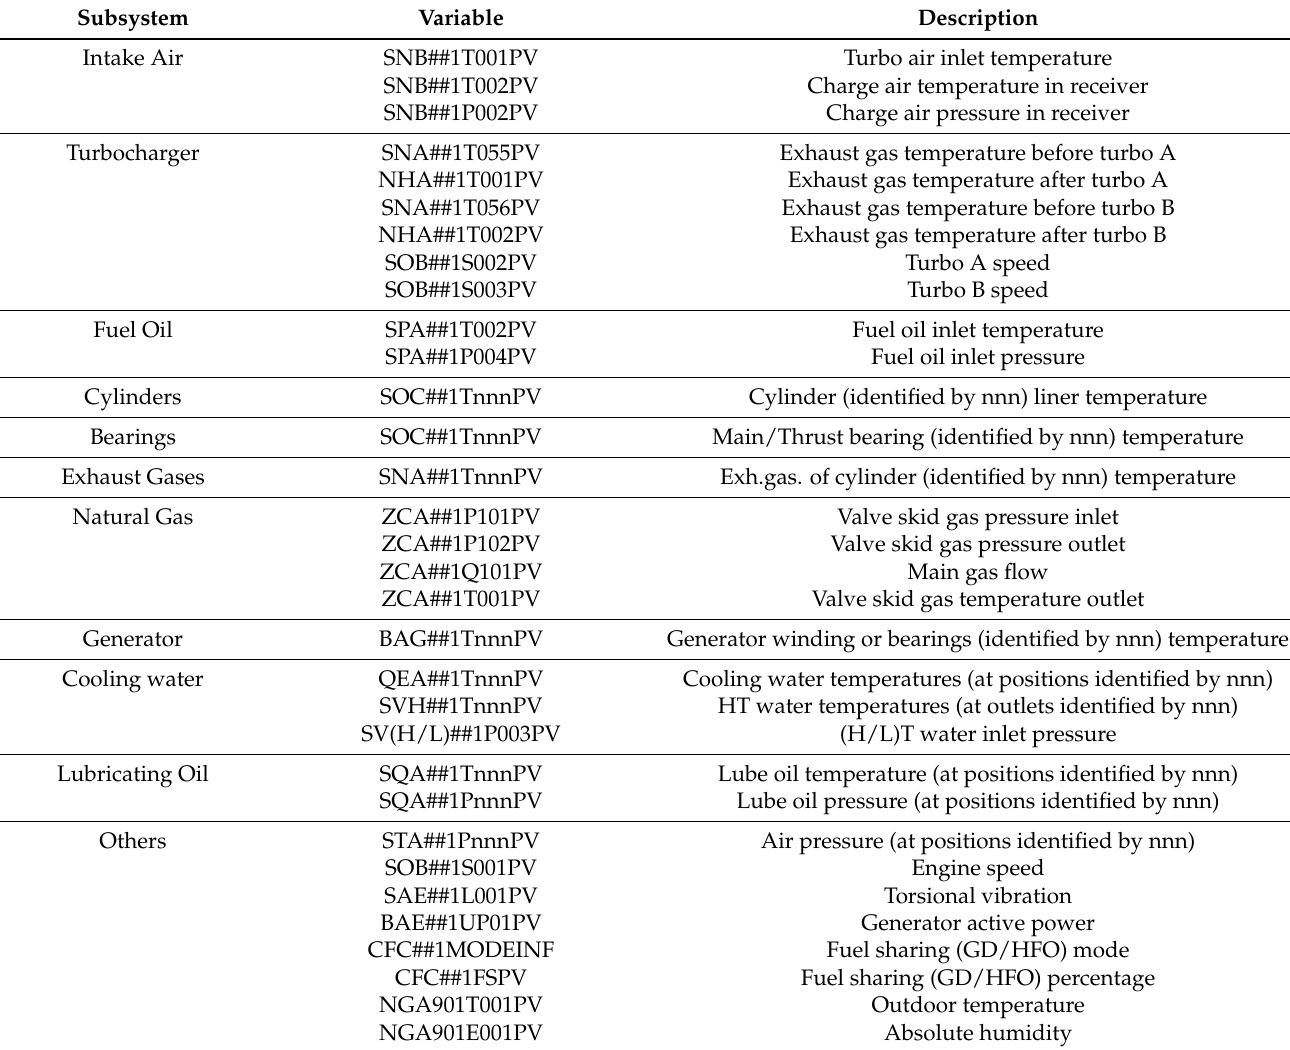
Table 1. Distribution of variables from the subsystems of generator unity number